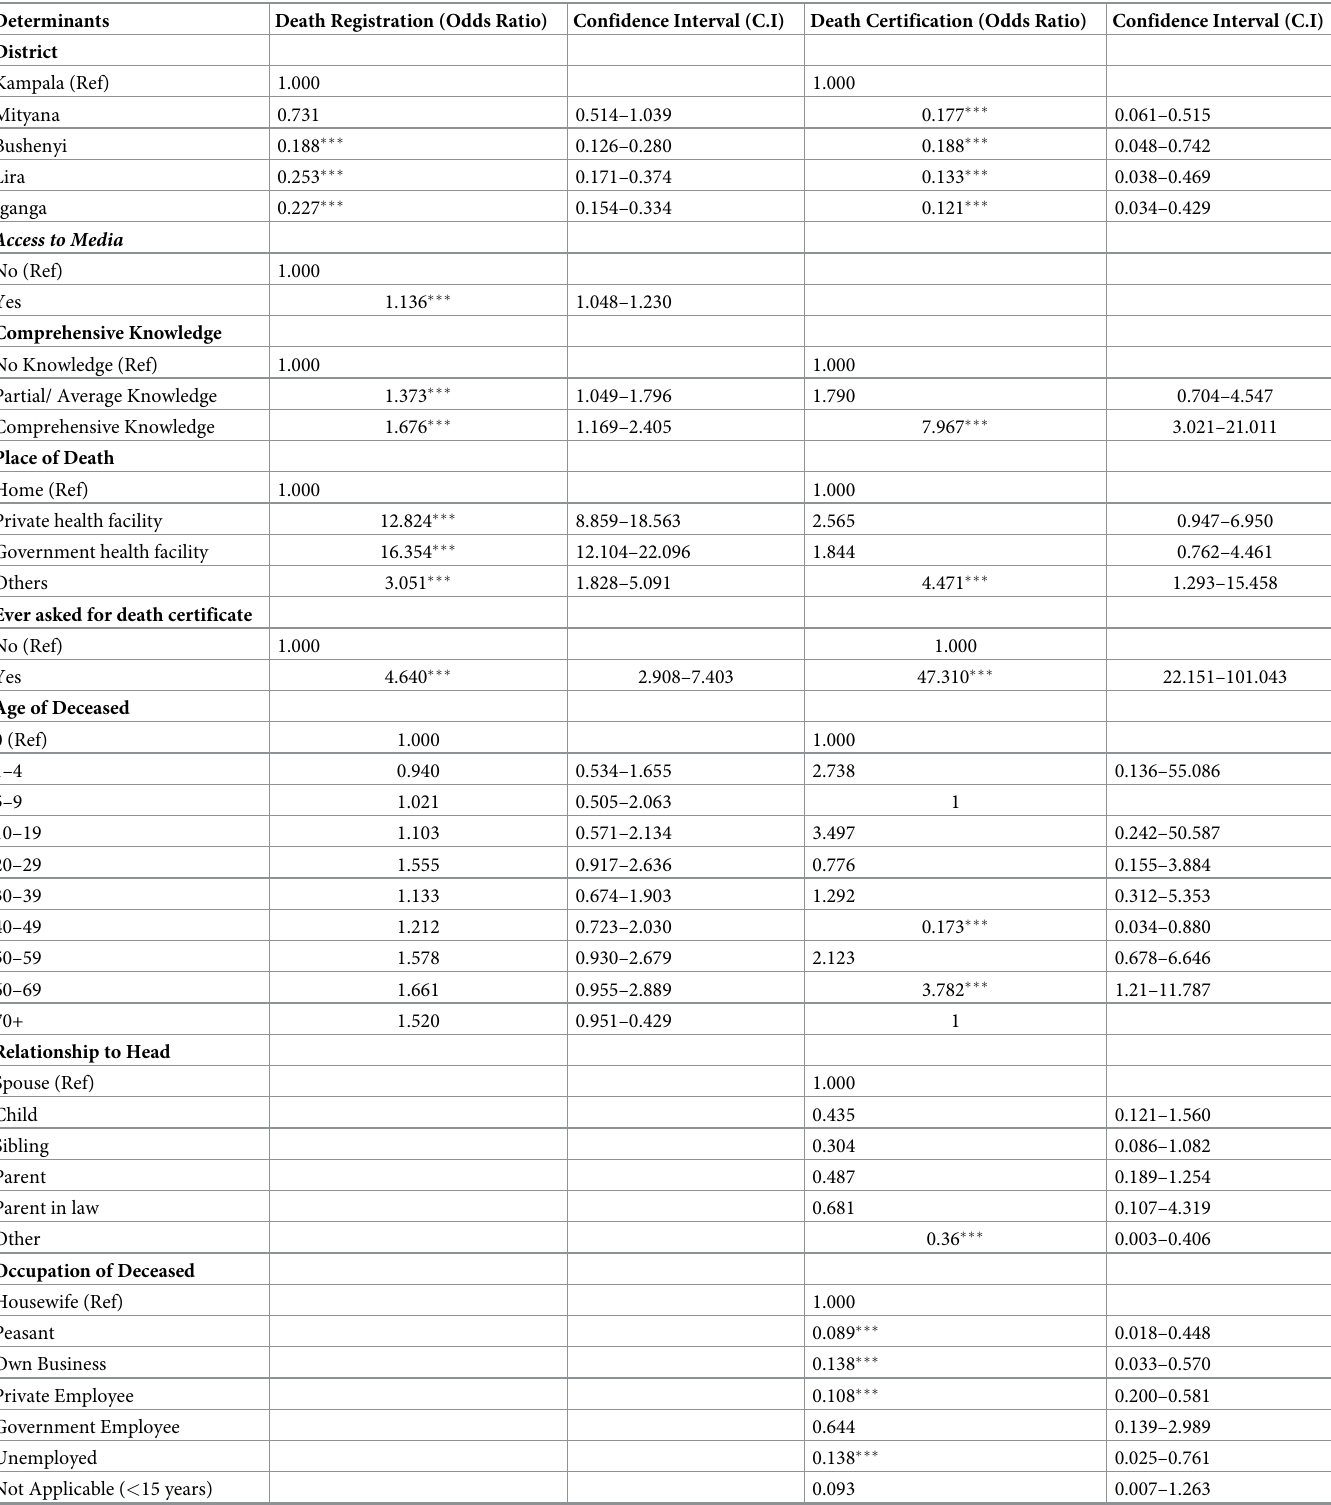
Table 4. Determinants of death registration and death